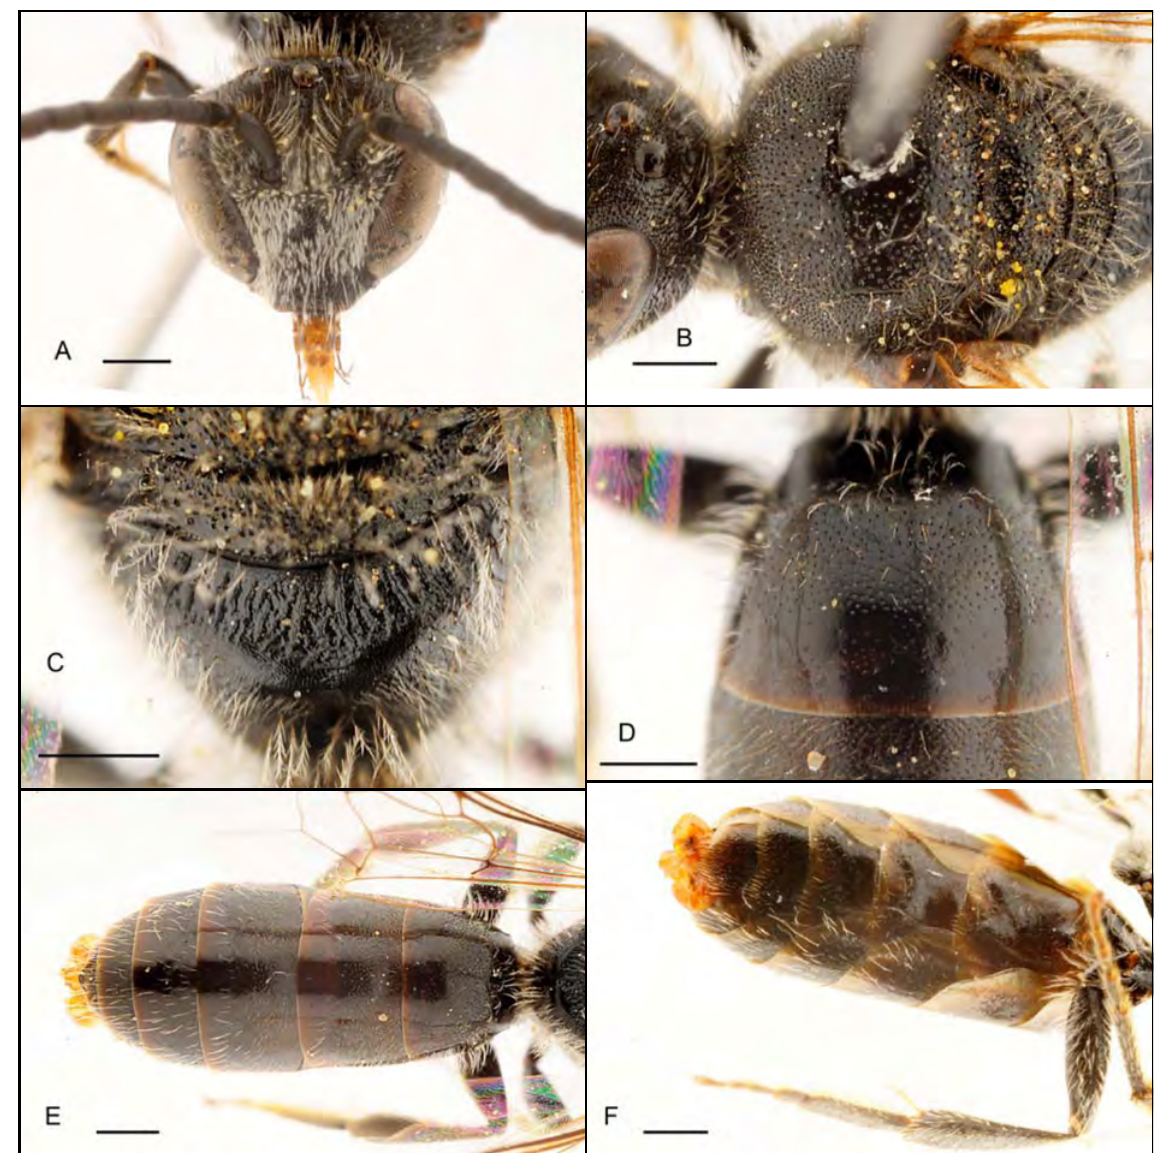
Fig. 8. Lasioglossum ( Capalictus ) timmermanni sp. nov., ♂. A . Head. B . Mesosoma and vertex. C . Propodeum and metanotum. D . First tergum. E . Metasoma, dorsal view. F . Metasoma, ventral view. Scale line = 0,5